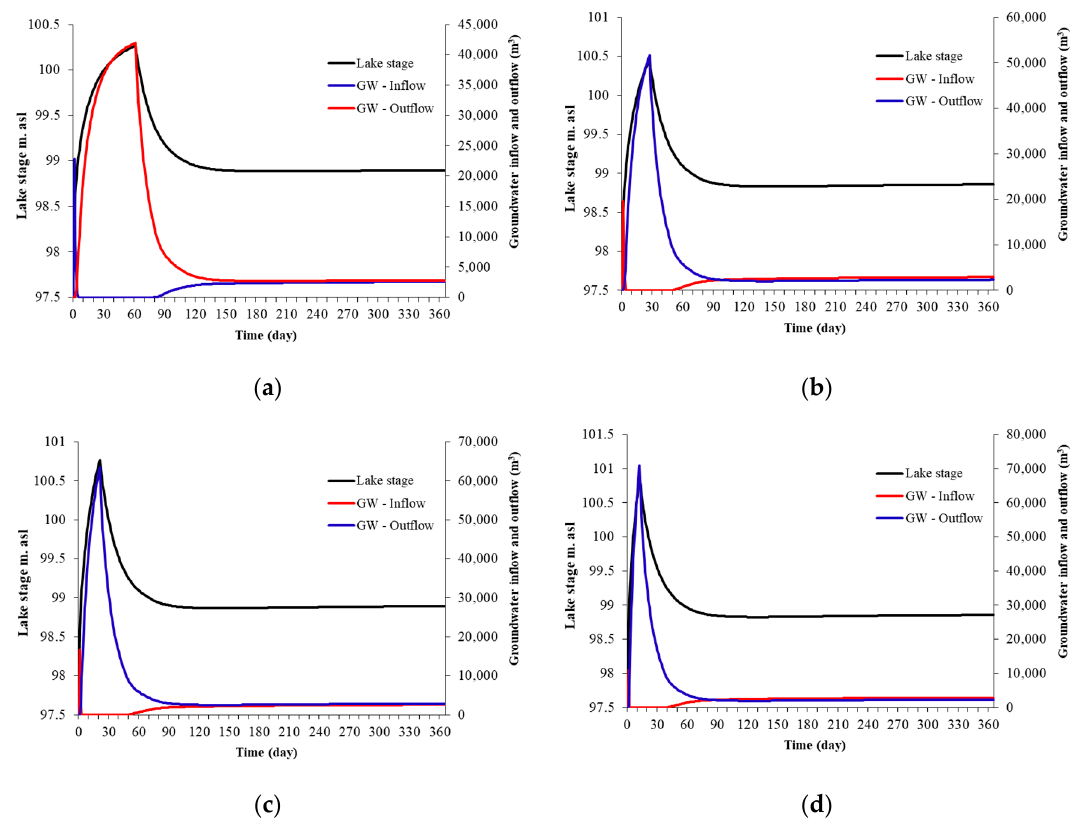
Figure 8. Daily variability of Lake Korcsina stage, groundwater seepage into the lake (GW-Inflow), seepage from the lake into groundwater (GW-Outflow), and net lake seepage (LAKnet) during the simulation period of one year. Note that the fluxes are referenced to the temporally variable lake with different feeding discharge from the stream. ( a ) Feeding at Q = 0.5 m 3 s − 1 , ( b ) Q = 0.75 m 3 s − 1 , ( c ) Q = 1.0 m 3 s − 1 , ( d ) Q = 1.5 m 3 s − 1